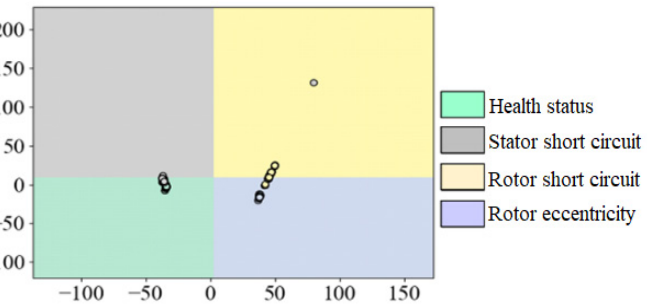
Figure 7. Classification result without the fuzzy process after removing the average unbalanced force.